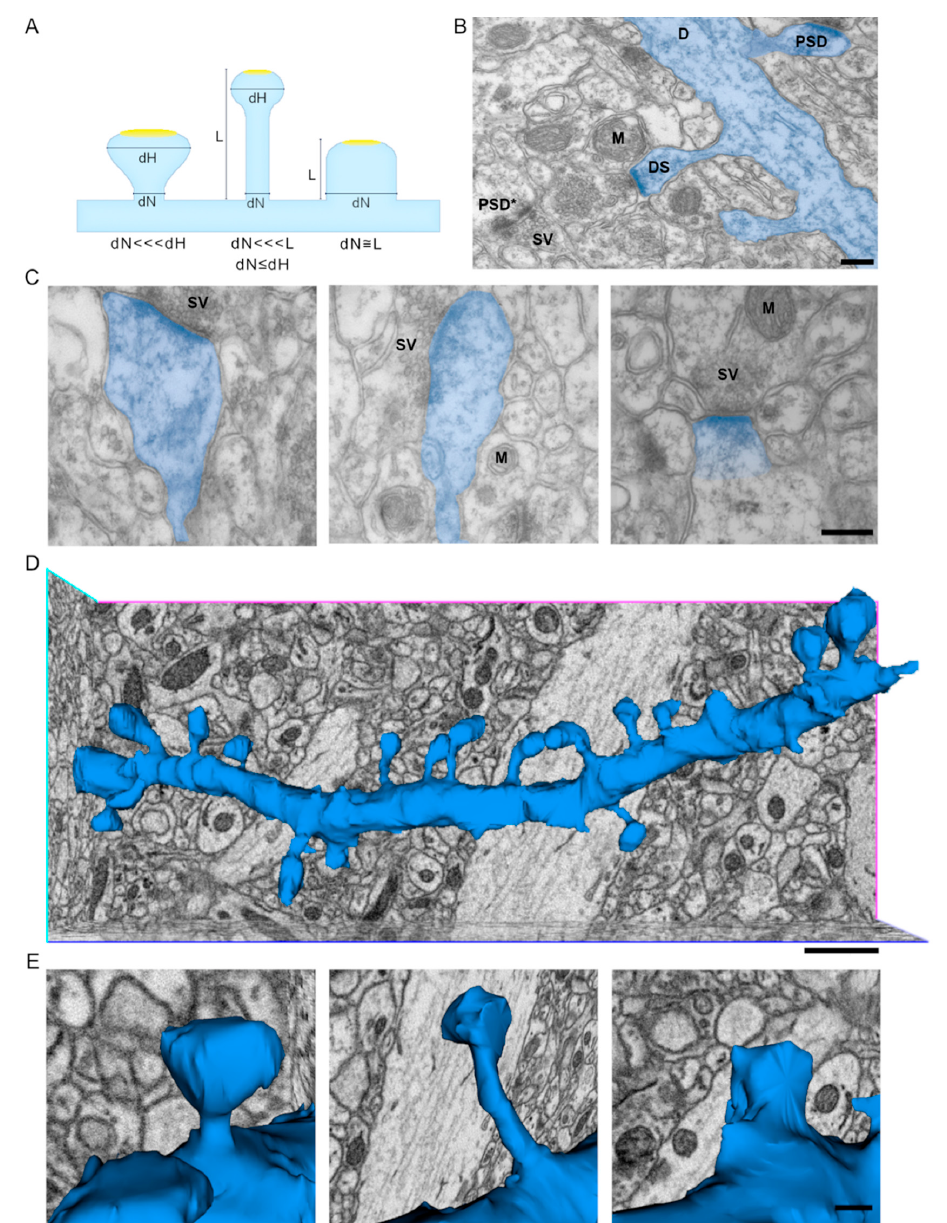
Figure 1. Appearance of dendritic spines in 2D TEM images and in 3D volume rendered dendrite from a volumetric data-set. ( A ) Canonical classification of dendritic spines based on optical microscopy observation and criteria for the attribution of spines to each class, based on the neck (dN) and spine head diameter (dH), and spine length (L). Dendritic spines are defined as mushroom (dN <<<dH), thin (dN<<<L, dN ≤ dH) or stubby (dN ≅ L); filopodia are not depicted here. Modified from [8]. ( B ) Representative TEM image of mouse hippocampal CA1 neuropil where a segment of a dendrite (D, highlighted in blue) and several excitatory synapses can be seen. In this image it is possible to see few dendritic spines (DS) arising from the dendritic shaft and, within excitatory synapses, the post synaptic densities (PSD) are clearly detectable; among them, a complex post synaptic density (PSD*). The presynaptic terminal is recognizable by the presence of synaptic vesicles (SV). (M: mitochondria; scale bar = 200 nm). ( C ) Representative TEM images of sections of mouse hippocampal CA1 showing respectively mushroom (left), thin (center), and stubby (right) dendritic spines (highlighted in blue) (M: mitochondria, SV: synaptic vesicles; scale bar = 200 nm). ( D ) 3D reconstruction of a representative CA1 dendrite of the mouse hippocampus, the dendrite is segmented and extracted from a stack of independent projections obtained with SBF-SEM (scale bar = 1 µ m). ( E ) Higher magnification images of selected spines arising from the dendrite depicted in D. From left to right we can appreciate the 3D aspect of mushroom, thin and stubby spines (scale bar = 200